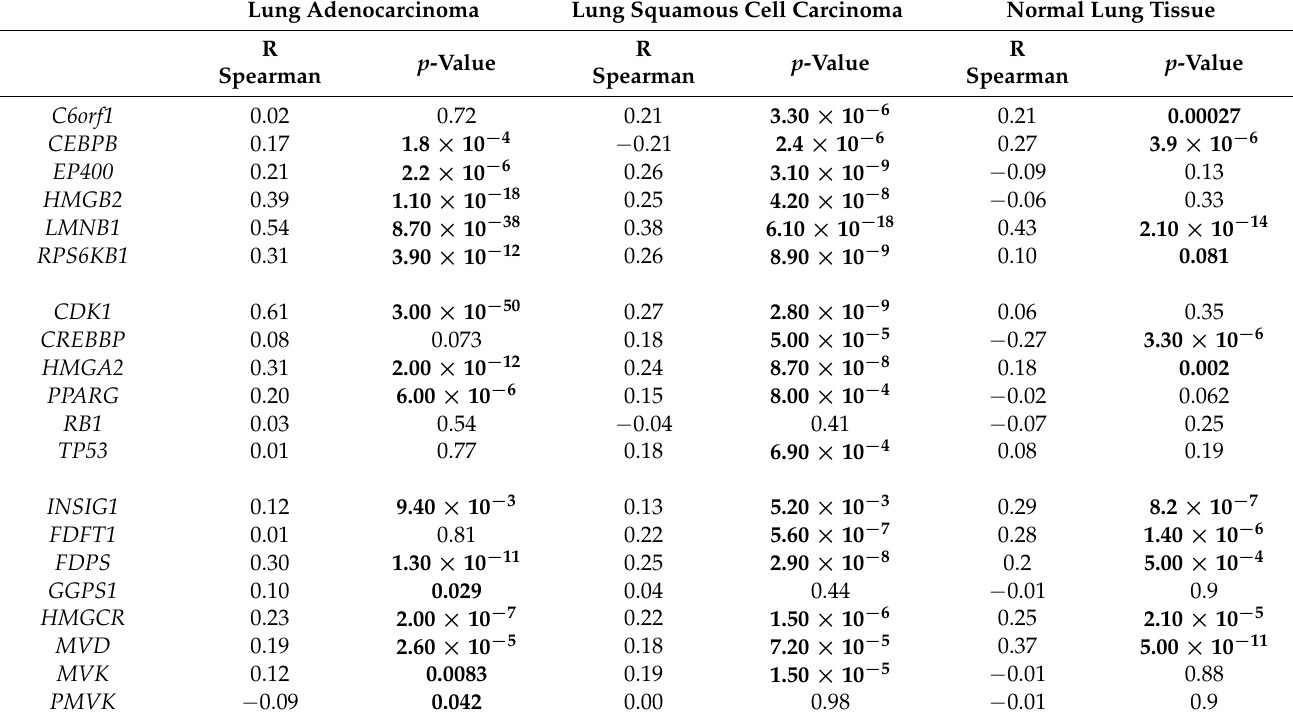
Table 3. Correlation between expression levels of the HMGA1 and the genes coding putative in- teracting proteins in lung adenocarcinoma, lung squamous cell carcinoma, and normal lung tissue. Calculated by GEPIA. Lung Adenocarcinoma Lung Squamous Cell Carcinoma Normal Lung